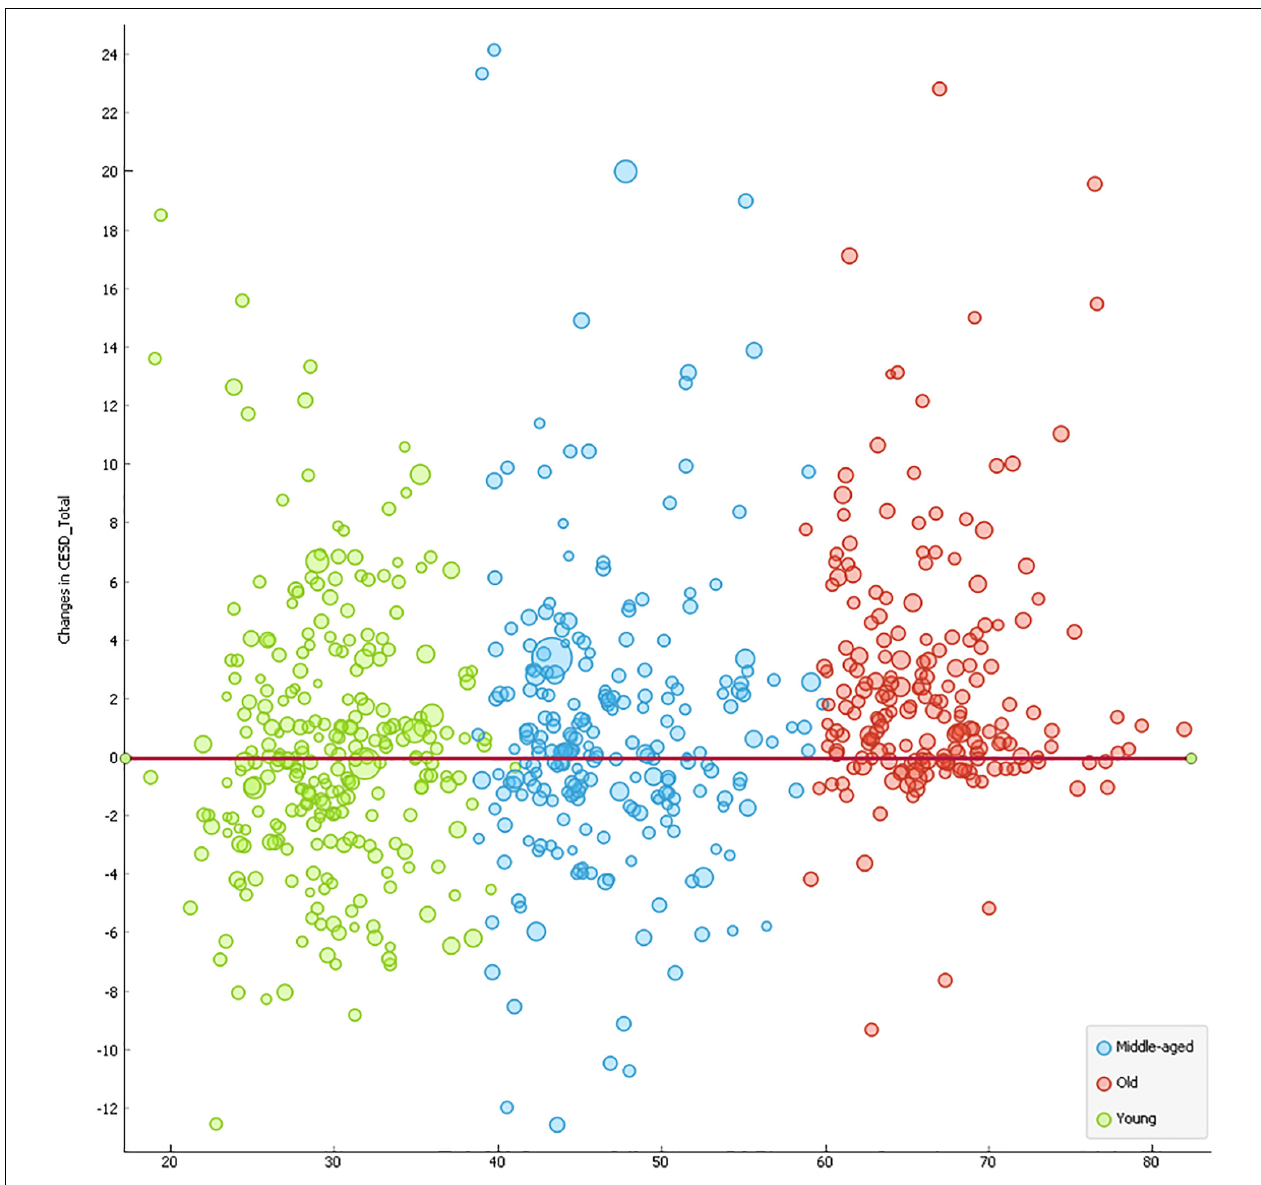
FIGURE 2 | Scatterplots of changes in mental health outcomes by age. The size of the circle was indicative of the individualistic variation in BMI. The red line indicates the benchmark for zero net change in CESD between January and